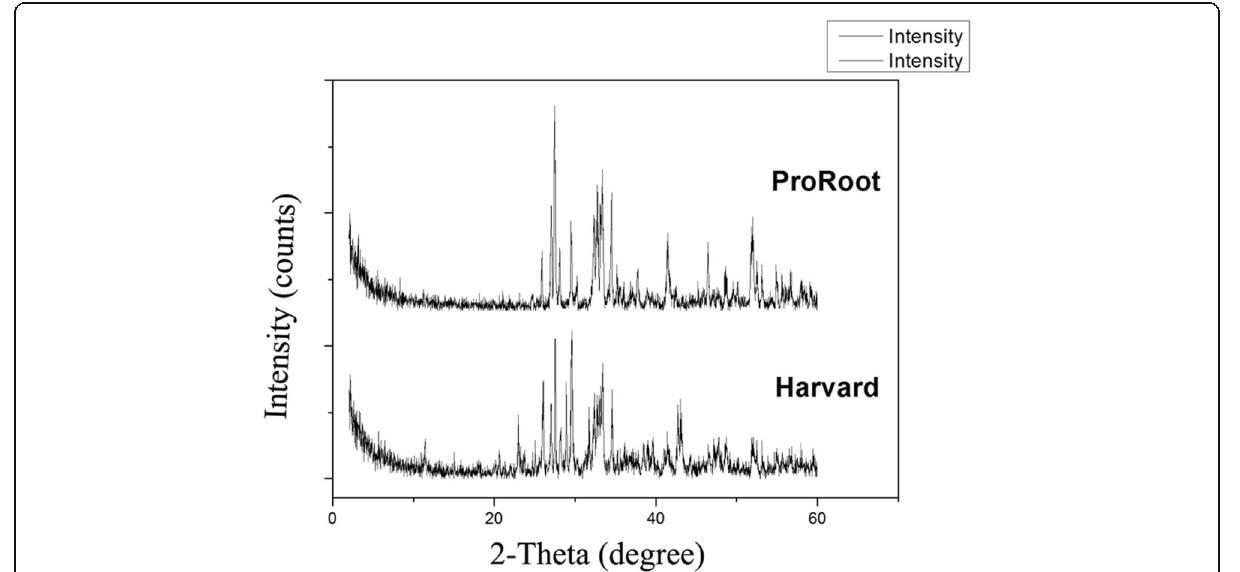
Fig. 1 XRD patterns of Harvard and ProRoot endodontic cements